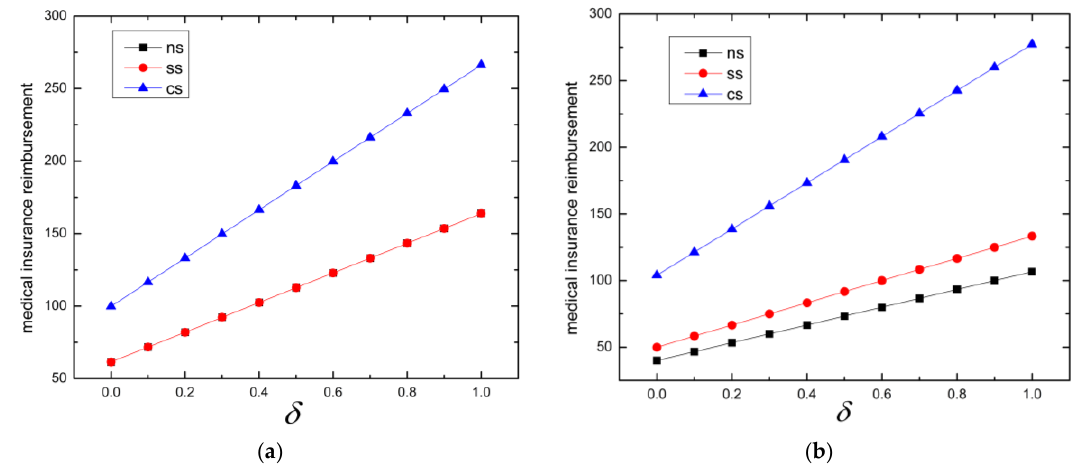
Figure 2. Medical insurance reimbursement under different reference price effects: ( a ) reimbursement for superior hospital; ( b ) reimbursement for subordinate hospital.